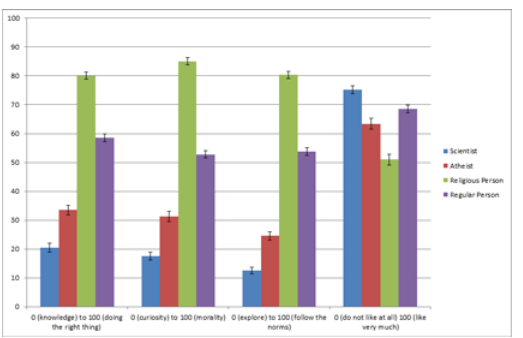
Fig 3. Evaluations of preferences and values, and likability, of the target groups (Study 10). Within items, all means differ significantly from each other at p < .01 (Bonferroni adjusted); the only non-significant difference was liking of atheists versus regular persons). The third item was presented to participants from 0 ( follow the norms ) to 100 ( explore ), but reverse-scored in the current Fig. Error bars show standard errors of the mean.